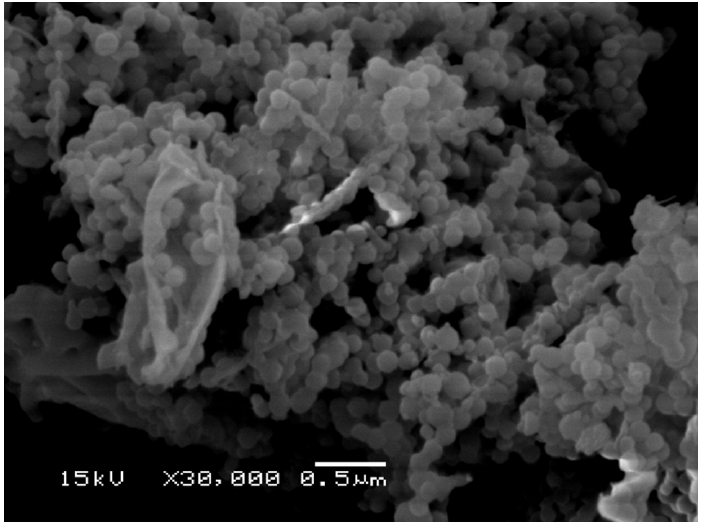
Figure 9. SEM micrograph of lyophilised BMO-PUL nanoparticles (Bar: 0.5 µm). In general, nanoparticles formulated from hydrophobically grafted materials have been more widely investigated with hydrophobic drugs, where high loading degree values (DL) have been reported compared to hydrophilic solutes [60–62]. In our study, a small water-soluble whitening agent, α -arbutin (Mw ~272 Da, Log P − 1.49) [63], that is known to possess inadequate skin permeability was utilised as a model therapeutic to explore the loading ability and release profiles of BMO-PUL nanoparticles [33,34]. α -arbutin was loaded by formulation via nanoprecipitation, and the DL (as determined by RP-HPLC) was calculated utilising Equation (2); values of 16.1 ± 2.2% were obtained. Rationalised by the fact that skin pH ranges between 4 and 7, α -arbutin released profiles were investigated in two different buffers, namely phosphate-citrate buffer (PCB, pH 5) and phosphate-buffered saline (PBS, pH 7) [64]. A similar pattern can be witnessed in both buffered solutions: a relatively fast discharge in the initial stage (0–2 h), continued by an incremental discharge for the following several hours (Figure 10a). This may be described by an initial discharge of adsorbed α -arbutin on the nanocarriers surface, prior to that entrapped within the matrix. A slightly faster release of α -arbutin was observed in mildly acidic buffer (PCB) compared to that of neutral pH (PBS), as shown from the slope of the line following linear regression (Figure 10b). This is likely due to fact that α -arbutin is a weak base (pKa ~10) that ionises more readily at acidic pH as compared to neutral, which facilitates its dissolution and release from the matrix of nanoparticles